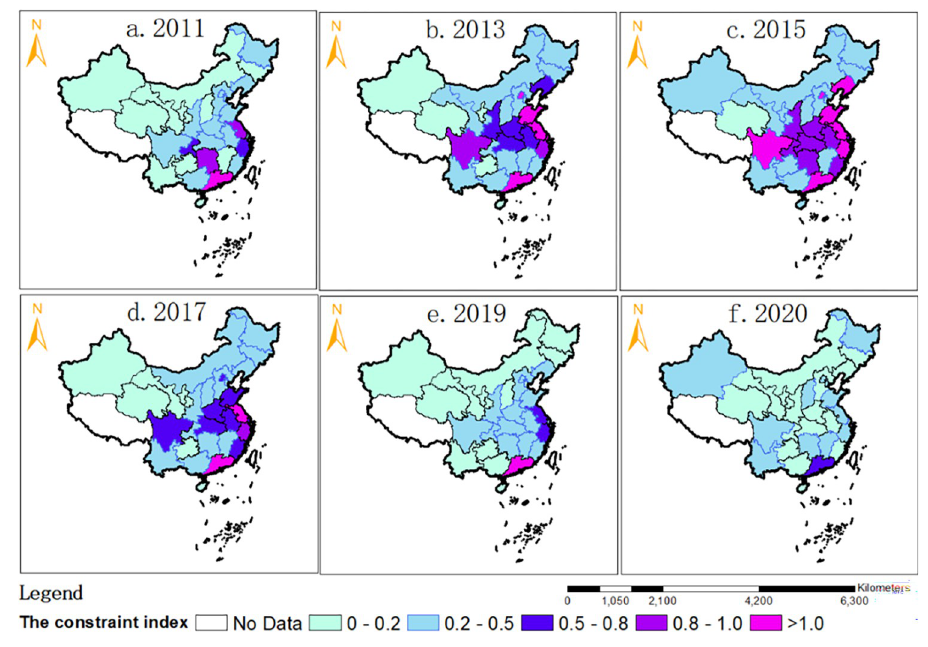
Fig 5. Spatial distribution of Zhou’s constraint identification index in